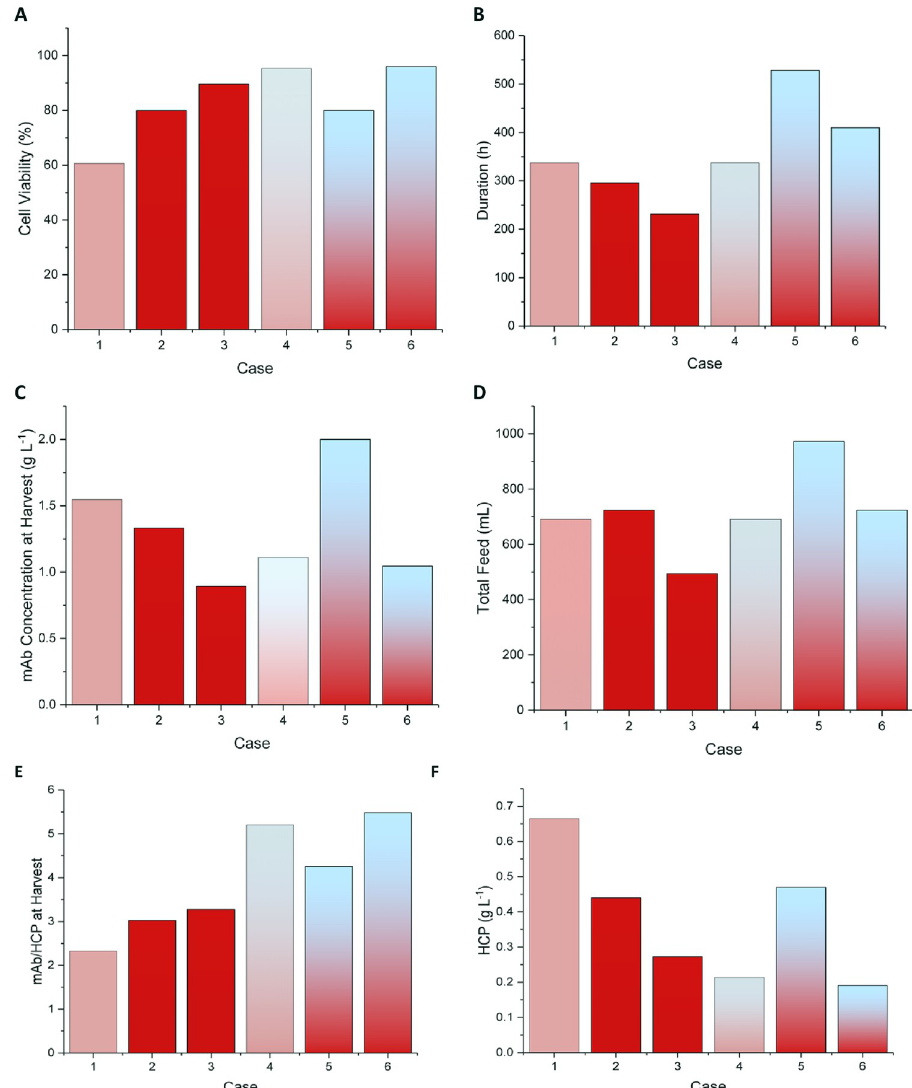
Fig 4. Results for the six optimisation scenarios shown in Table 1 for: (A) culture viability, (B) bioreactor run duration, (C) mAb concentration at harvest, (D) total feed input, (E) mAb/HCP concentration ratio, (F) HCP concentration at harvest. Cases 1 and 4 are the control experiments (standard cases) at physiological and mild hypothermic conditions, respectively, which were used for parameter estimation. The first three cases are for cultures grown under physiological temperature whereas cases 4–6 are cultures operated with a shift to mild hypothermia. The optimum temperature downshift time is after 140 h and 100 h for cases 5 and 6, respectively.